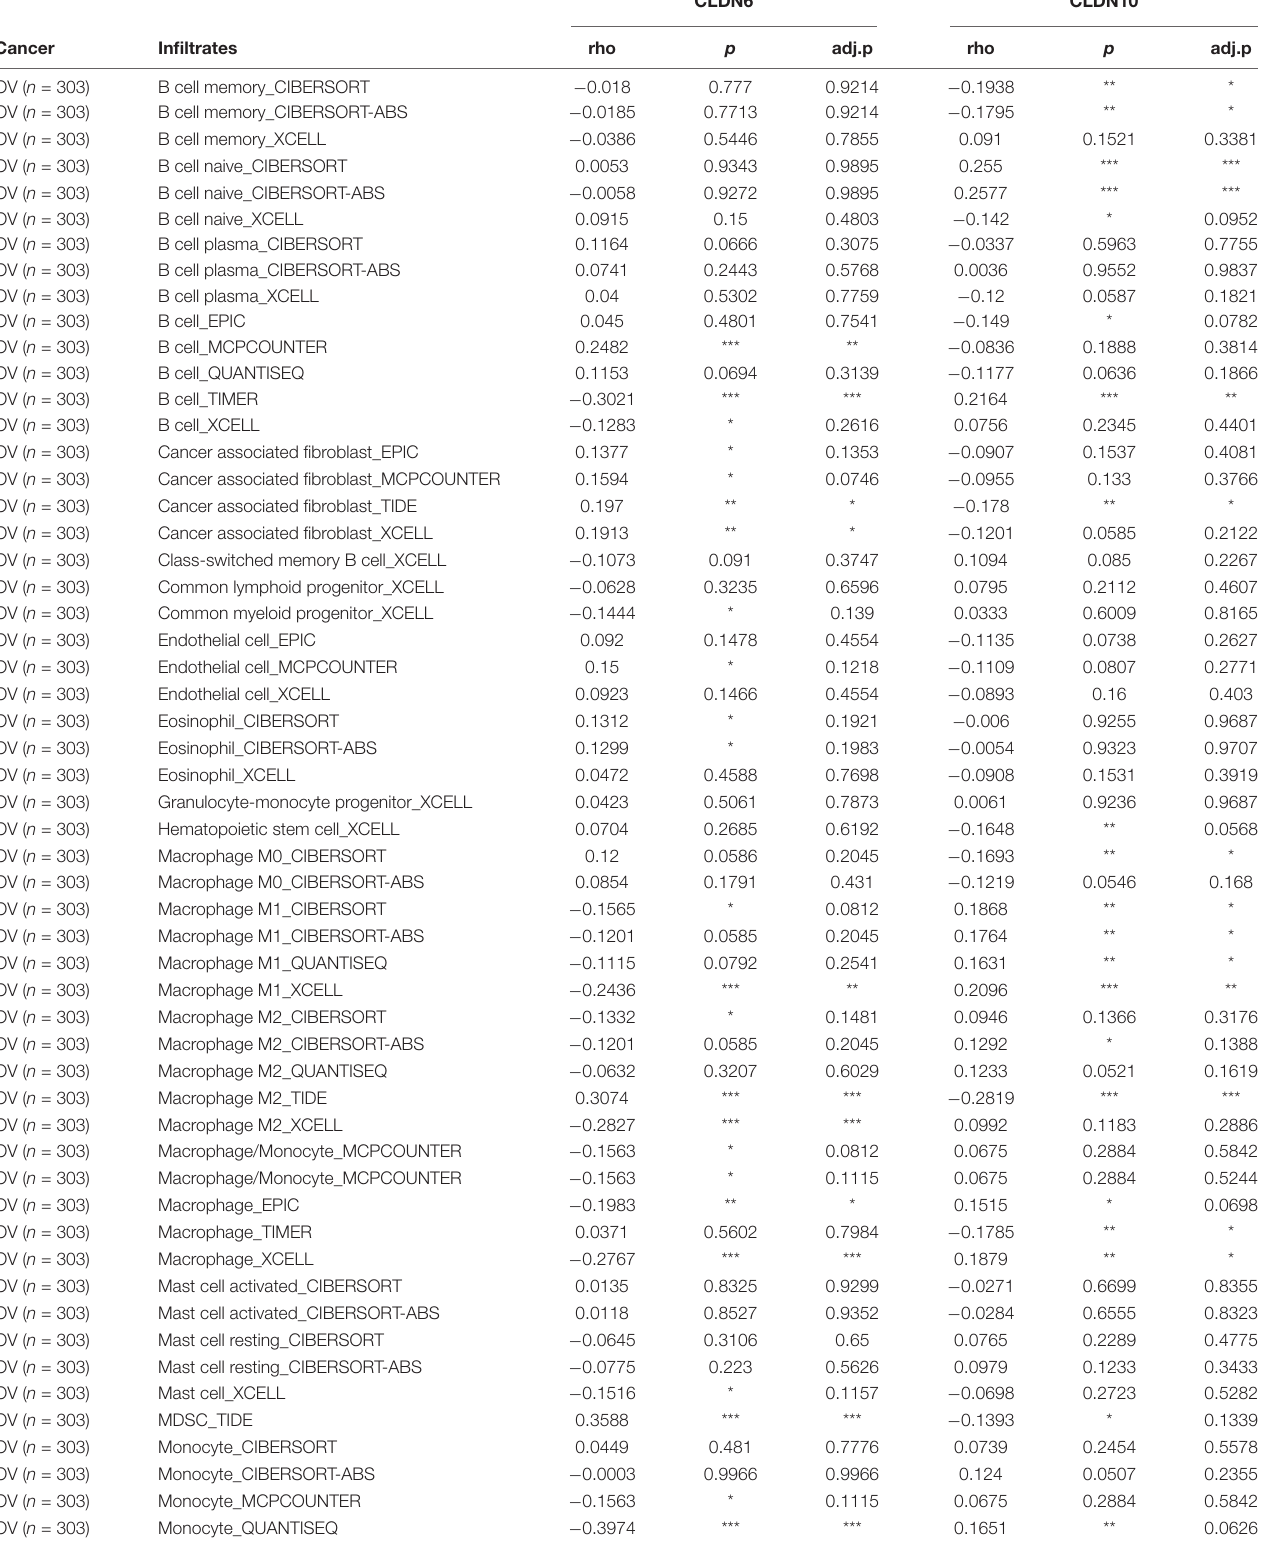
TABLE 2 | Correlation analysis between claudins and immune infiltration in ovarian cancer via TIMER2.0.